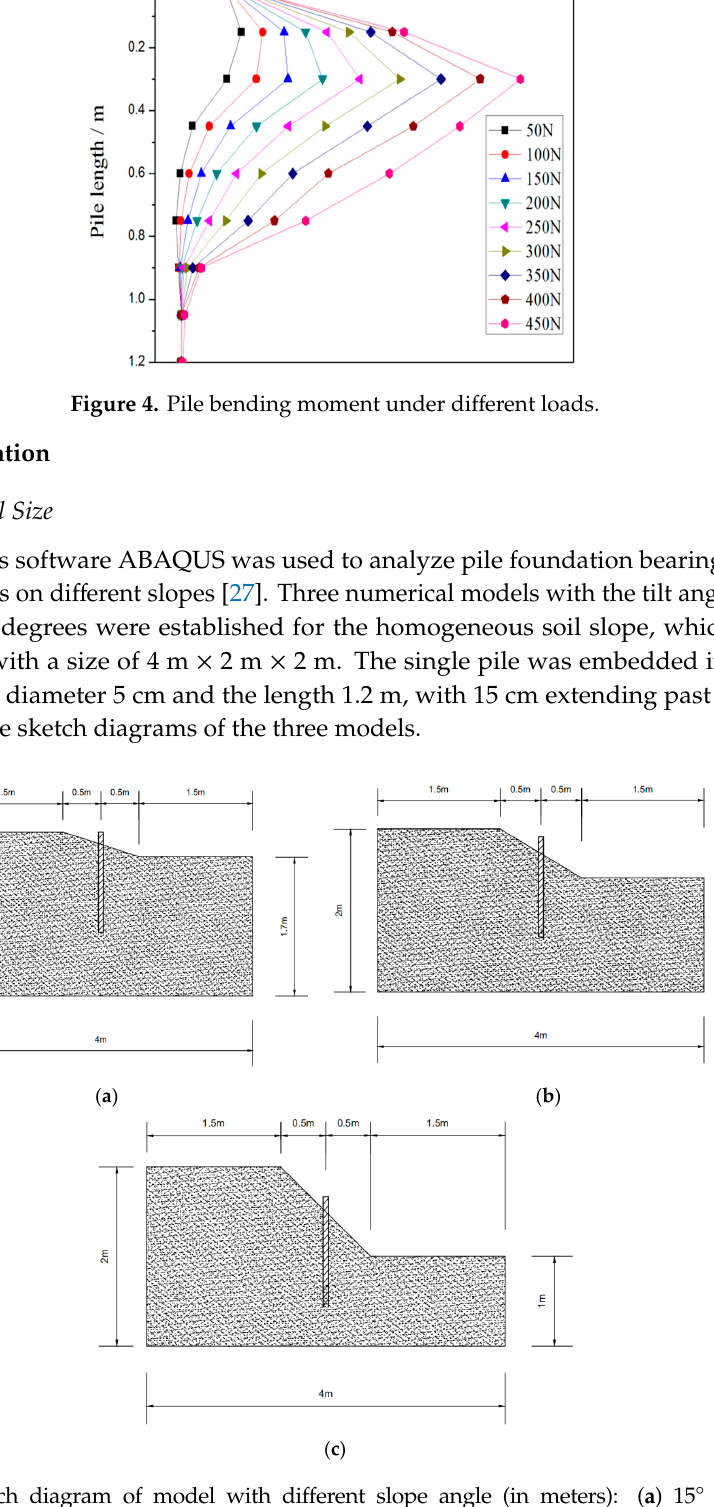
Figure 3. The curve of the pile’s load–displacement under lateral load.